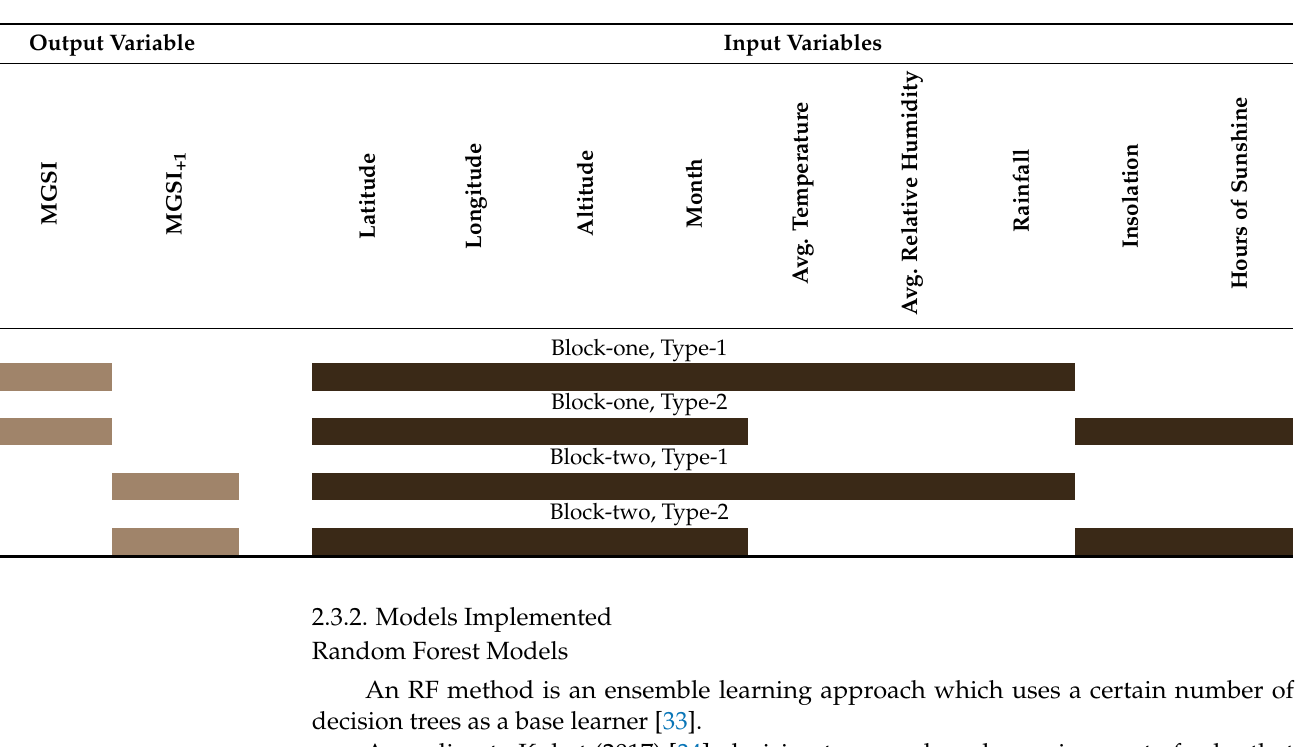
Table 2. Variables combination that had been used to develop the different kinds of model used in this research. The output variable is indicated in brown shading and the input variables are indicated in dark brown shading. Adapted from Puga-Gil (2022)